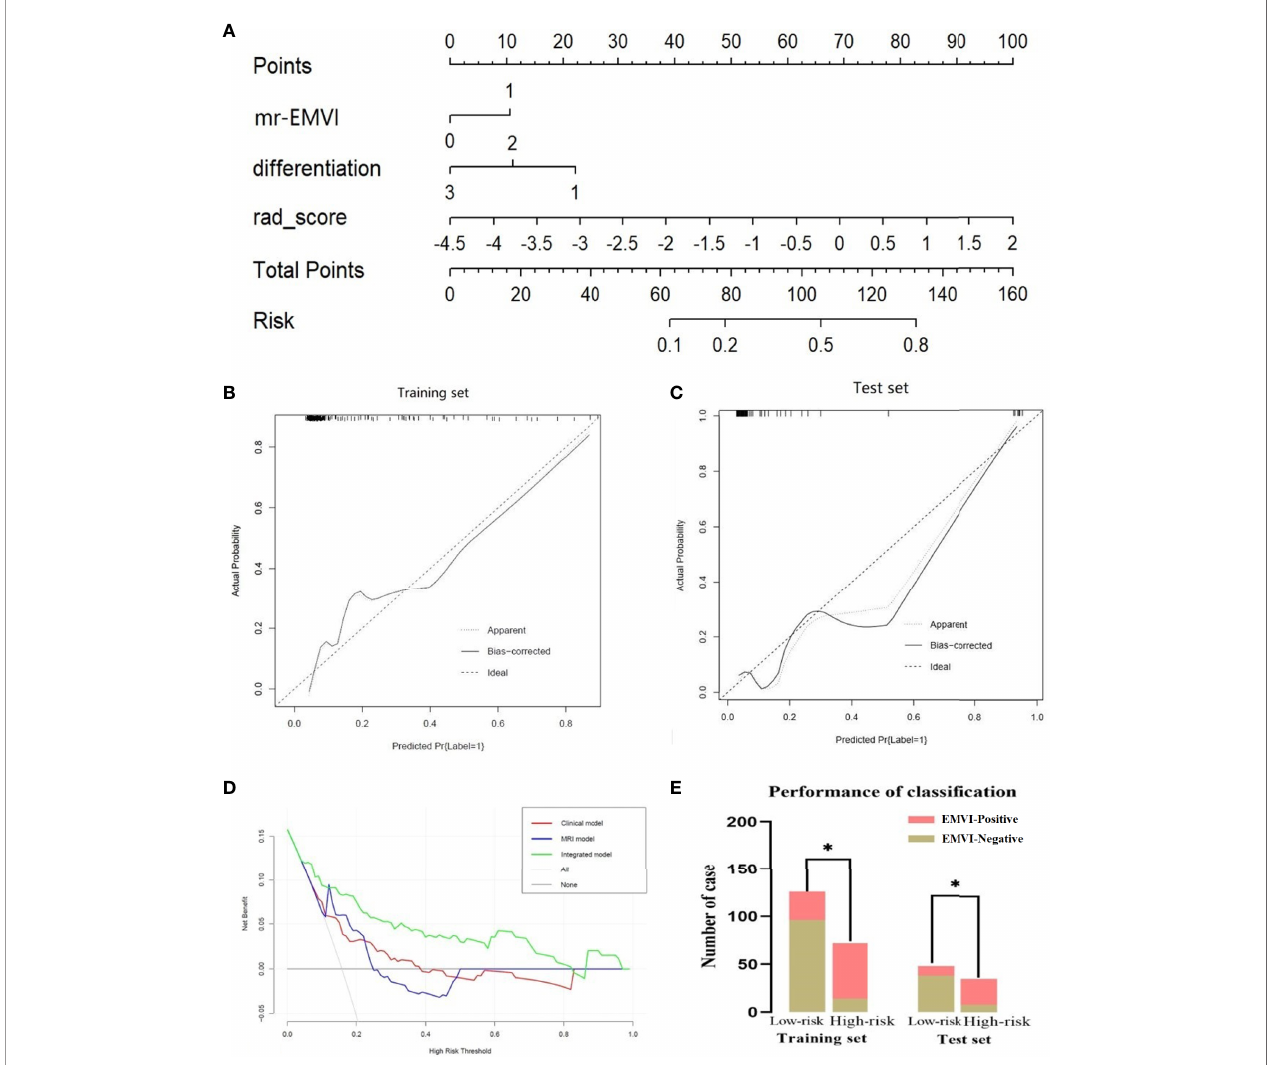
FIGURE 6 | Radiomics nomogram for detecting EMVI (A) . In the nomogram, a vertical line was drawn according to the value of the rad score to determine the corresponding value of points. The points of mrEMVI and differentiation stage can also be determined in the same way. The total points were the sum of the three points above. Finally, a vertical line was drawn according to the value of the total points to determine the probability of EMVI. The calibration curve of the radiomics nomogram for EMVI in the training set (B) and test set (C) . A dashed line indicated the reference line where an ideal nomogram would lie. A dotted line indicated the performance of the nomogram, while the solid line indicated bias correction in the nomogram. DCA curve (D) for the integrated model, MRI model and clinical model predicting EMVI in the dataset. The graphs showed that the integrated model had the greatest net bene fi t. The risk classi fi cation performance of the integrated model in the training and test set (E) . * P < 0.05.